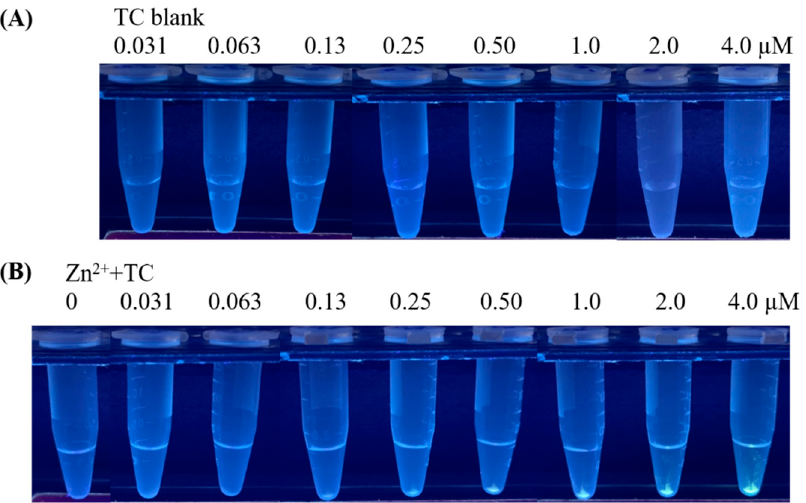
Figure 2. Photographs of the samples containing TC at different concentrations ( A ) without and ( B ) with adding Zn 2+ (1.49 mM) obtained after centrifugation (15,000× g rpm, 10 min). ( B ) with adding Zn 2+ (1.49 mM) obtained after centrifugation (15,000 × g rpm, 10